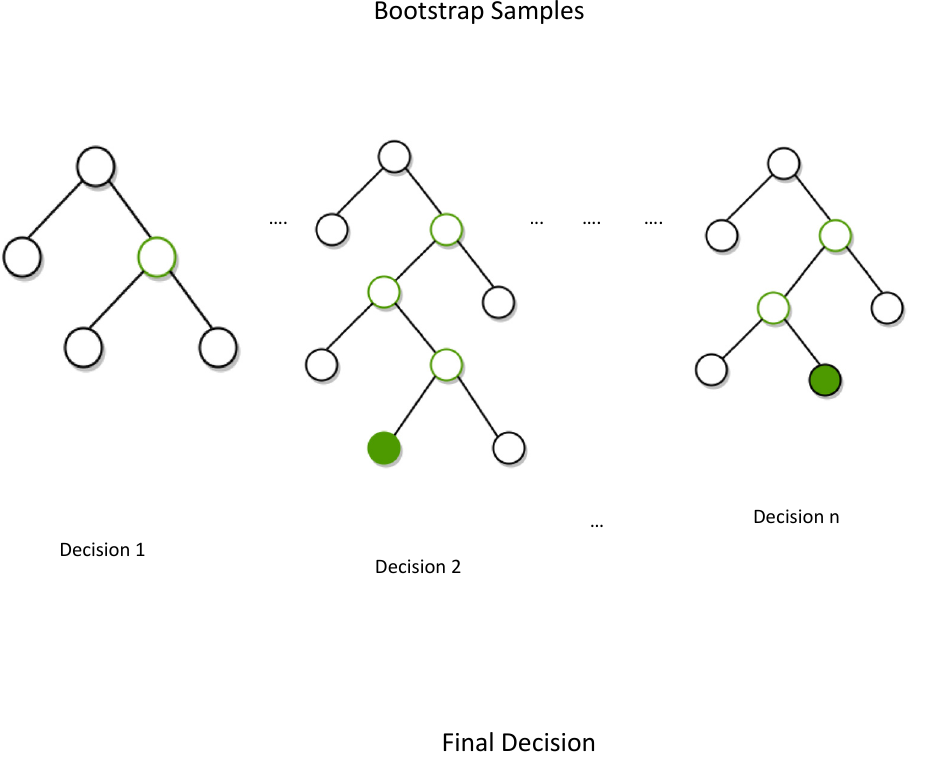
Figure 5. RF procedure. Each tree is built over a bootstrap sample (about 2/3 of the samples) of data and is used as a training set, in order to predict the data in the remaining 1/3, which is instead used as a test set sample (out-of-bag samples, or OOB) [17,36]. When a decision is made, the best predictor is identified and split on until the final decision is reached [37].